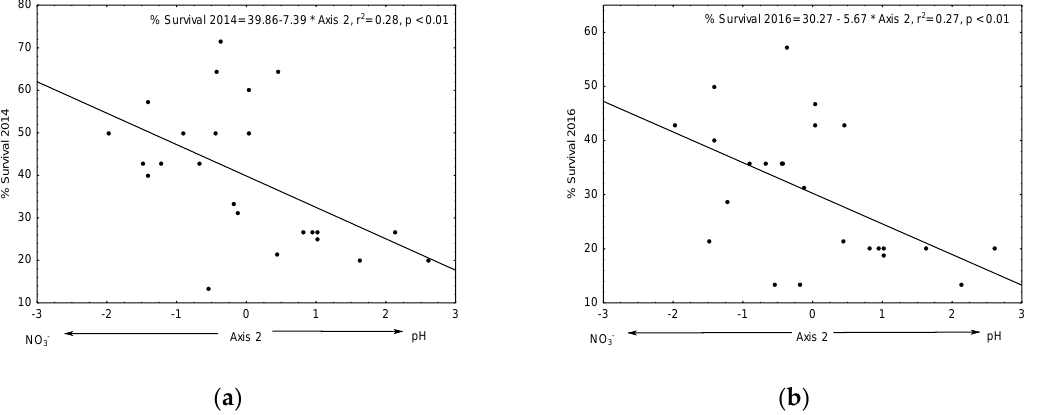
Figure 6. Regression of survival as a function of PCA scores of soil properties in 2014 (a) for survival in 2014 and (b) survival in 2016 for slow-growing tree species. Value of r 2 , regression line, and equation are shown.